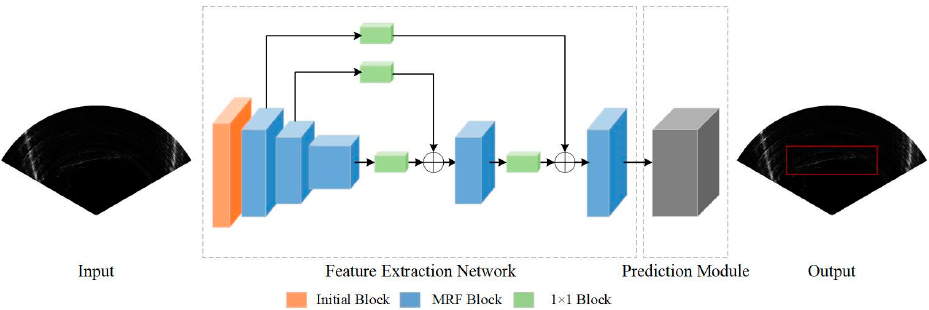
Figure 3. An illustration of multiple receptive field network (MRF-Net) architecture.